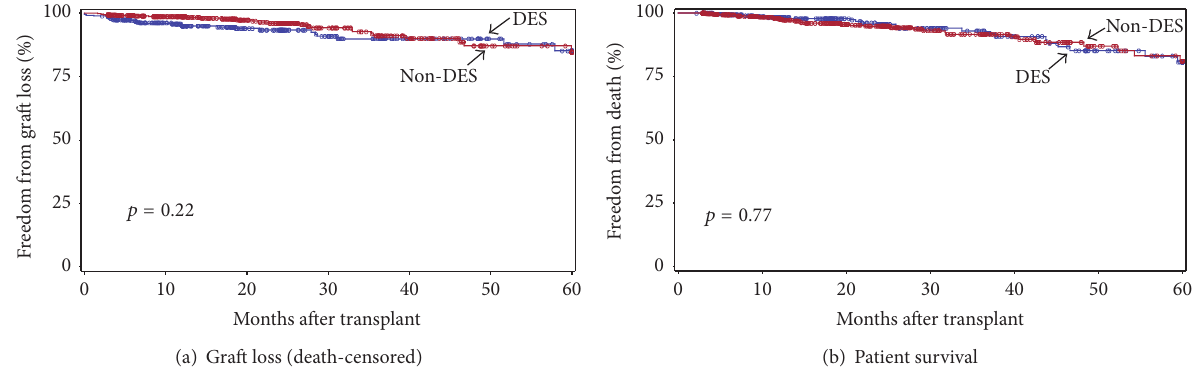
Figure 9: Freedom from allograft loss (a) and patient death (b) in DES (blue) versus non-DES (red) patients during the 1st 5 years after transplant. The group differences were assessed by the log-rank test.